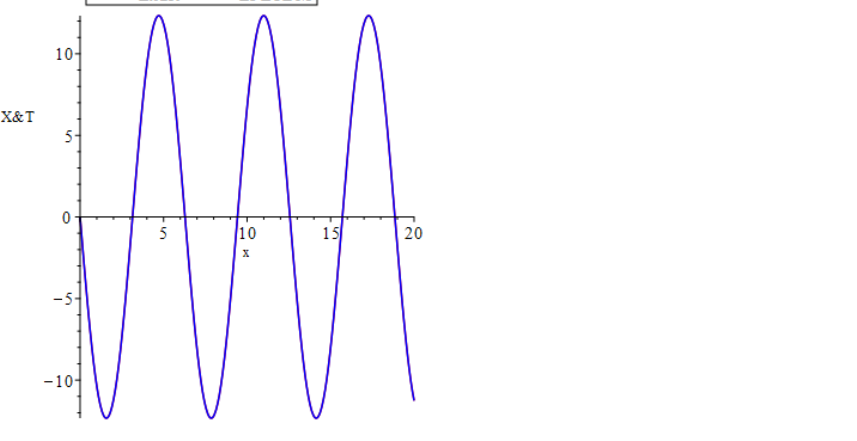
Figure 1. A comparison of the LFETDM solution and the exact solution of the system (38). The graph of LFETDM solutions for 𝑎𝑙𝑝ℎ𝑎 = 0.9, 𝑎𝑙𝑝ℎ𝑎 = 0.8, 𝑎𝑙𝑝ℎ𝑎 = 0.7, 𝑎𝑙𝑝ℎ𝑎 = 0.6 and the exact solution of the system (38) is shown in Figure